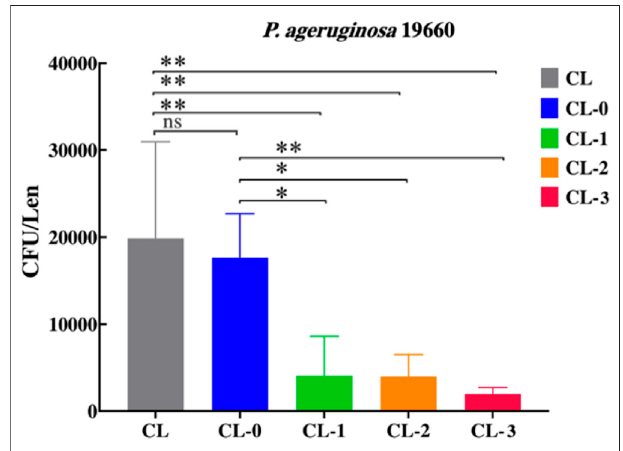
FIGURE9| Adhesionof P.aeruginosa onthecontactlensesdetermined by viable plate